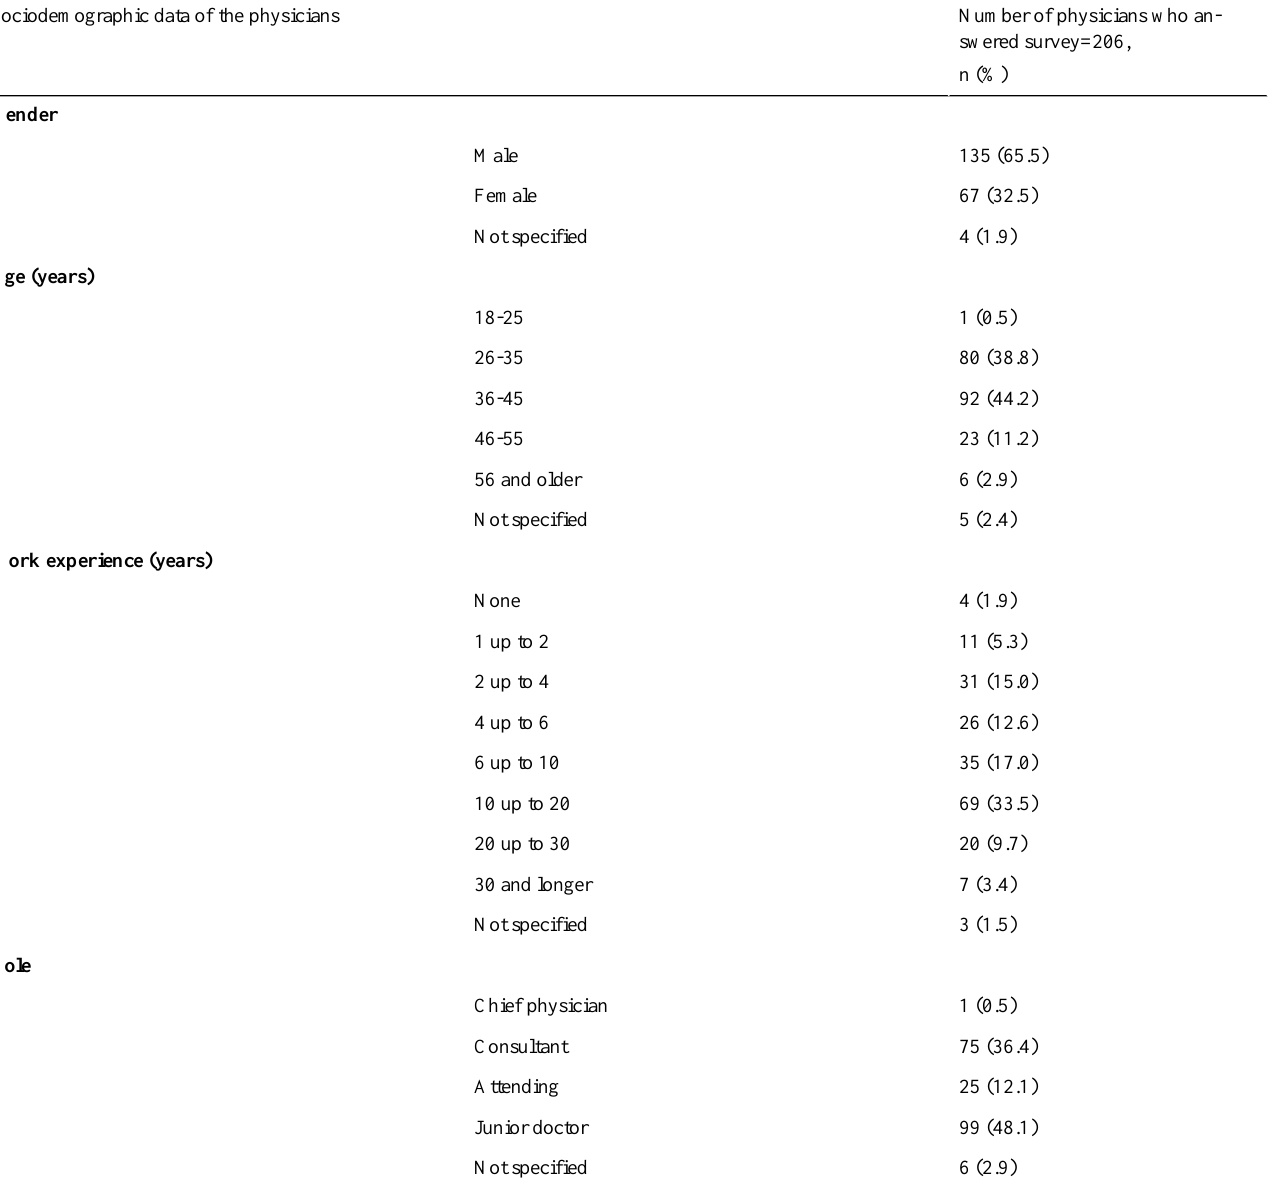
Table 1. Sociodemographic data of the physicians (206/1151) who answered the